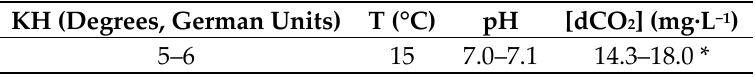
Table 2. Water parameters used to estimate the amount of dissolved CO 2 in